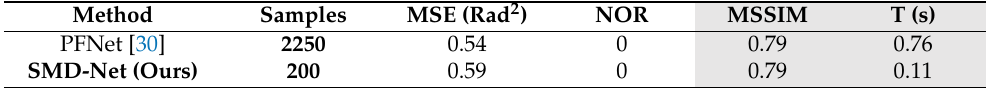
Table 4. The metrics of the PFNet trained with 2250 samples and the SMD-Net trained with 200 sam- ples on the simulated data. MSSIM is the core accuracy index. T is the speed